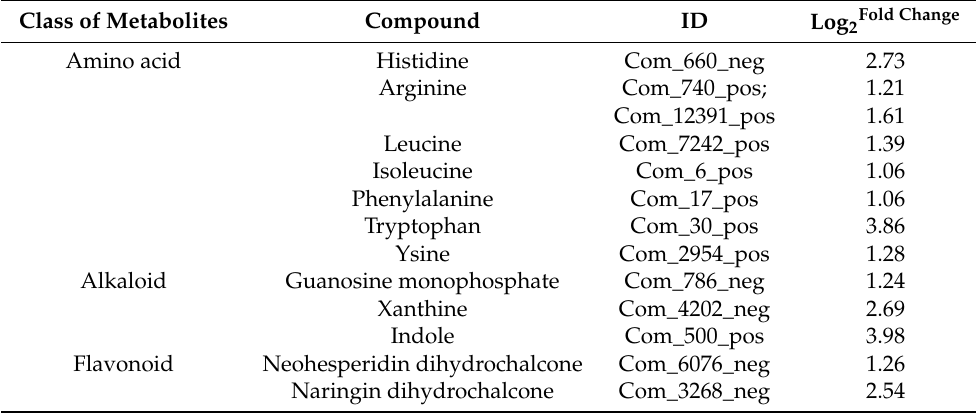
Table 2. Different bitter-tasting metabolites in the watercore